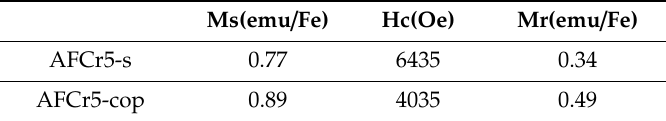
Table 2. Estimated Ms, Hc and Mr for AFCr5-s and